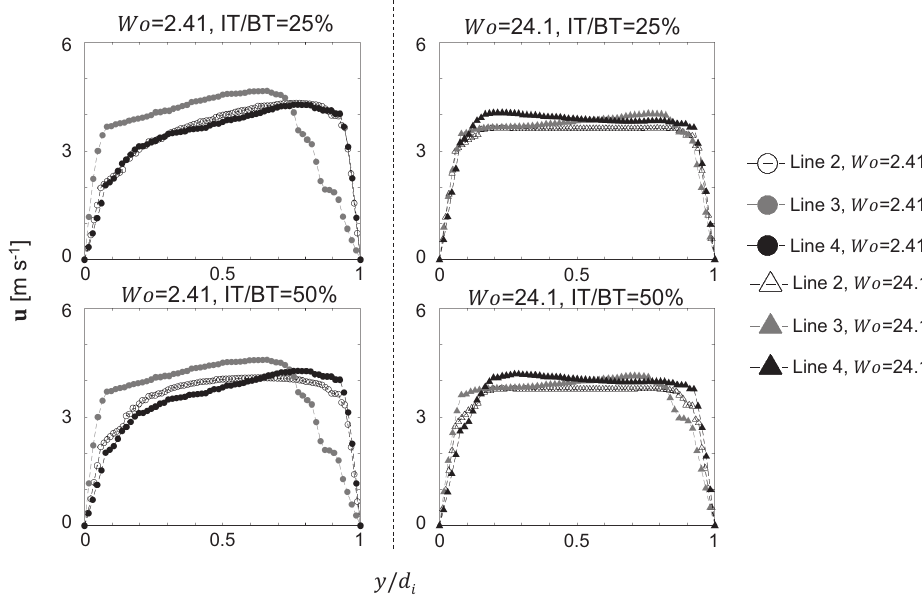
Figure 10. Velocity profiles at Planes 2–4 for varying Wo and IT/BT conditions. Three-dimensional velocity ( u ) extracted at lines 2–4 (refer Figure 1) is shown as a function of non-dimensional diameter y / d i , where d i is the airway cross-sectional diameter in Plane i (refer to Table